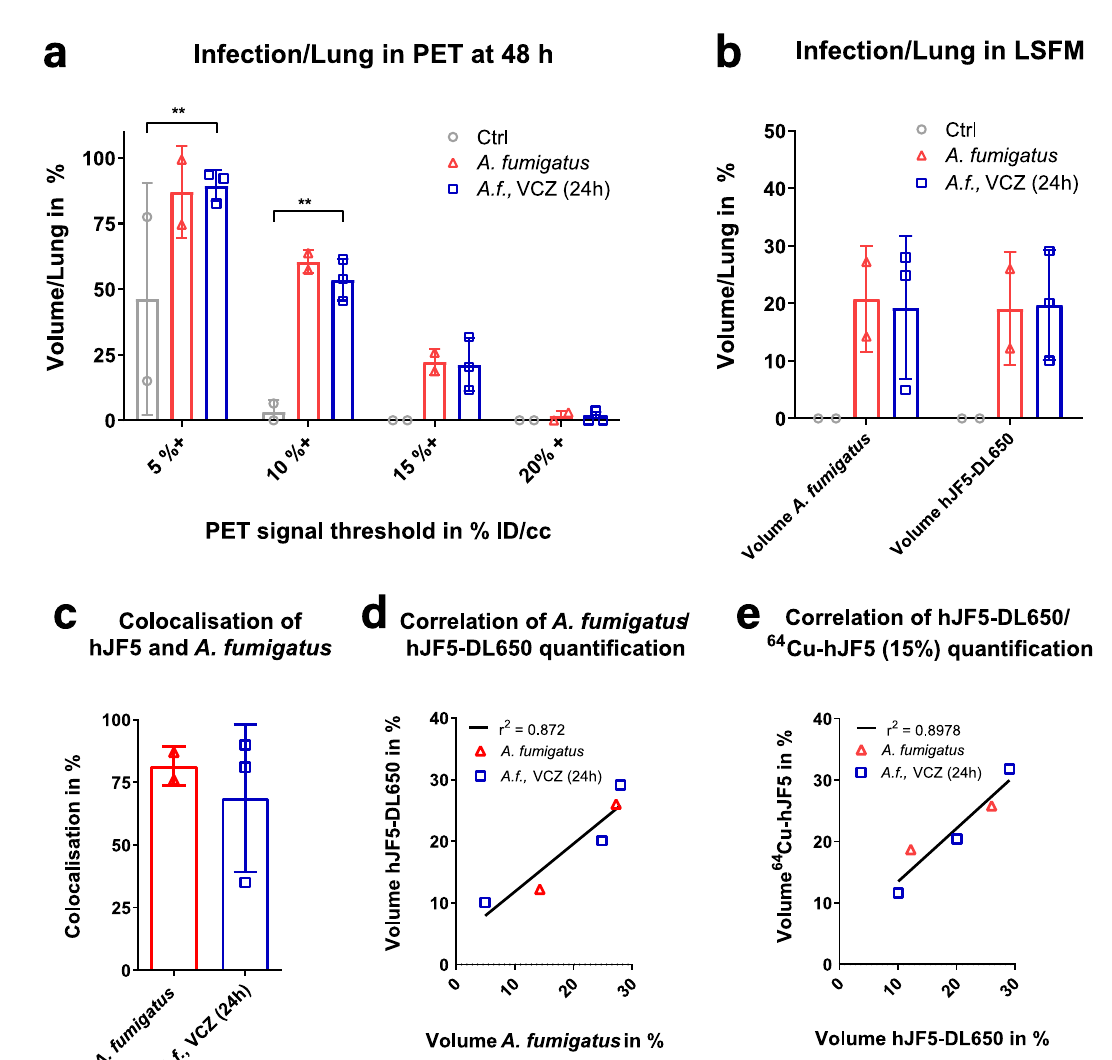
Fig. 4 Quanti fi cation and volumetric analysis of immunoPET and LSFM. a Ratio of infected lung volume as measured by immunoPET to total lung volume measured via MRI as a function of 64 Cu-hJF5-DyLight650 accumulation threshold in percent injected dose per volume (%ID/cc) at 48 h postinoculation in PBS-deposited animals (Control, left, n = 2), A. fumigatus -infected animals without treatment ( A. fumigatus , middle, n = 2) and animals with voriconazole treatment 24 h after inoculation ( A.f . VCZ (24 h), right, n = 3). 5%: Ctrl vs. A.f ., VCZ (24 h), p = 0.0062. 10%: Ctrl vs. A.f ., VCZ (24 h), p = 0.0013. b Volumetric ratio of A. fumigatus or 64 Cu-hJF5-DyLight650 in the lung as measured by LSFM for each group. c Quanti fi cation of the co-localization of 64 Cu-hJF5-DyLight650 and A. fumigatus tdTomato measured by LSFM in untreated ( A. fumigatus , red) and treated ( A.f ., VCZ (24 h)). d Correlation of A. fumigatus invasion and 64 Cu-hJF5-DyLight650 distribution in the lungs of A. fumigatus- infected animals untreated ( A. fumigatus , red) and VCZ treated 24 h after infection ( A.f ., VCZ (24 h) as measured by LSFM. e Correlation of 64 Cu-hJF5-DyLight650 volumetric distribution in the lungs of A. fumigatus -infected animals untreated ( A. fumigatus , red) and VCZ treated 24 h after infection ( A.f ., VCZ (24 h) as measured in LSFM and PET using the 15%ID/cc threshold. r 2 represents Pearson ’ s correlation coef fi cient. Results are plotted as individual values with average and standard deviation. p values were generated using two way ANOVA with Tukey ’ s multiple comparison test (* p < 0.05; ** p < 0.01; *** p < 0.001; **** p <